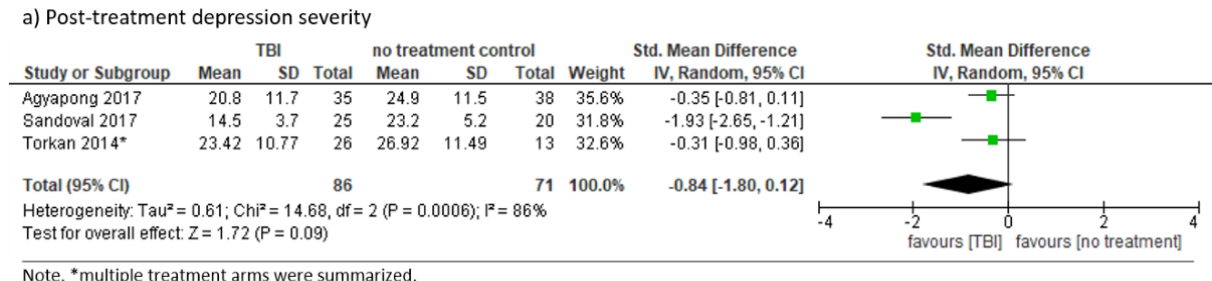
Figure 8. Forest plot for technology-based psychological intervention versus no-treatment